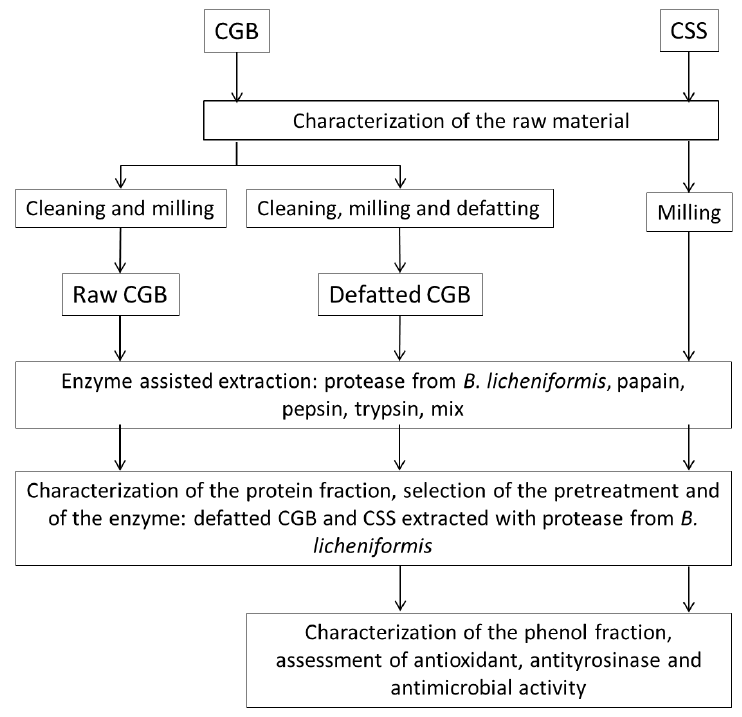
Figure 1. Experimental scheme showing the main phases of the